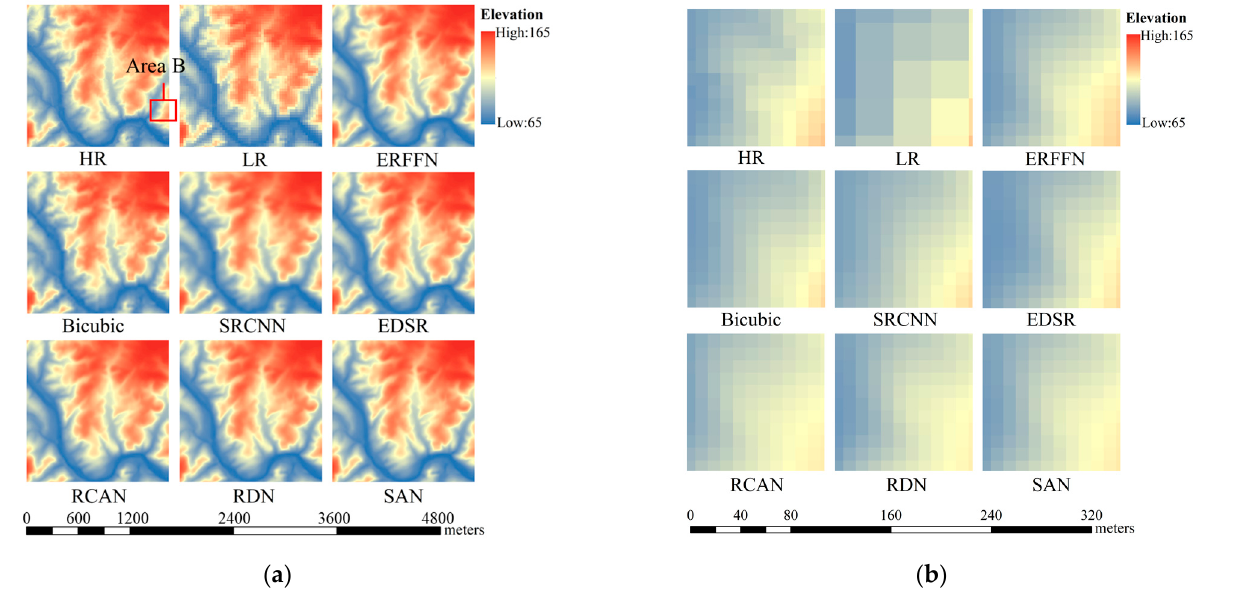
Figure 10. ( a ) The reconstruction of 10 m DEMs using different methods. ( b ) Zoomed in area B of ( a ).